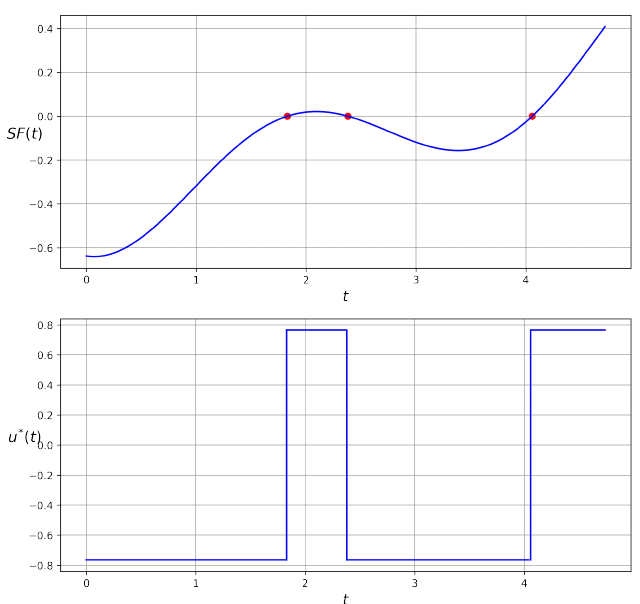
Figure 3. Switching function SF ( t ) and optimal control u ∗ ( t ) for ε =